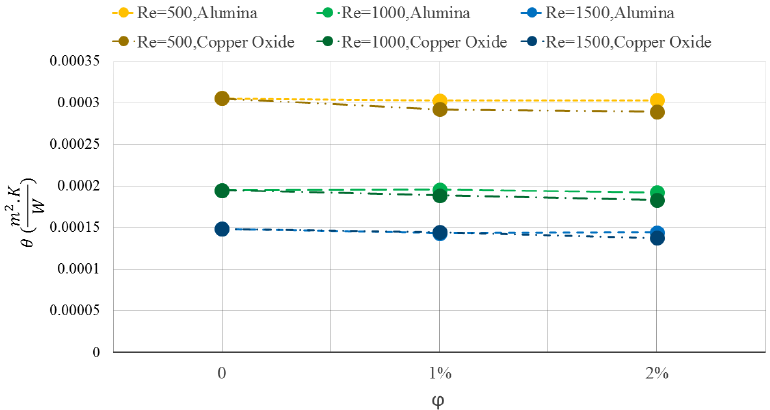
Figure 8. Temperature uniformity values on WMCHS for two different NFs at three Res.